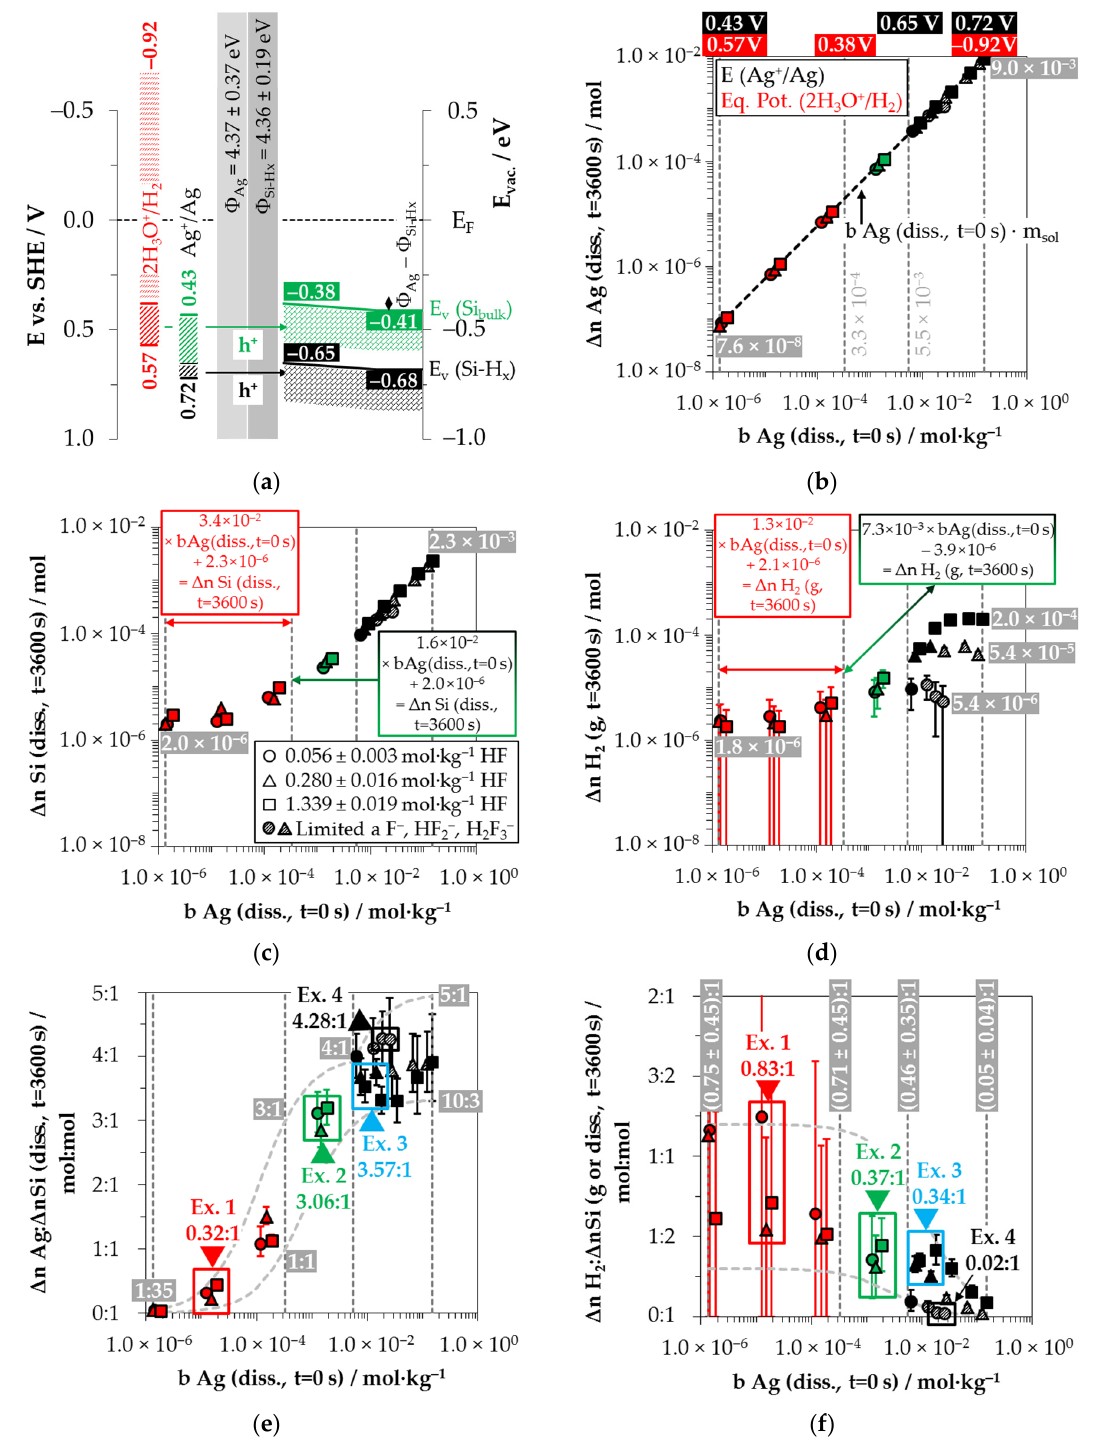
Figure 2. ( a ) Energy diagram of Ag + and H 3 O + reduction at the Ag/Si contact with the indication of the upper and lower limits of the redox strengths of the Ag + /Ag half-cell [28] and those of the equilibrium potentials of the 2H 3 O + /H 2 half-cell [33] and energetic levels of the valence bands of the bulk and hydrogen-terminated silicon ( E V (Si bulk ) [26,80,81], E V (Si-H x ) [82]) and their bending, based on the differences of Φ Ag and Φ Si-Hx [83–88] and the findings from [26]; ( b ) amounts of Ag deposition ( Δ n Ag ( diss., t = 3600 s)); ( c ) Si dissolution ( Δ n Si ( diss., t = 3600 s)); and ( d ) molecular H 2 formation ( Δ n H 2 ( g, t = 3600 s)) after t = 3600 s processing, as well as stoichiometric ratios of ( e ) Ag deposition and Si dissolution ( Δ n Ag : Δ n Si (diss., t = 3600 s)); and ( f ) stoichiometric ratios of molecular H 2 formation and Si dissolution ( Δ n H 2 : Δ n Si (g or diss., t = 3600 s)) relative to the initial Ag + molality b Ag ( diss., t = 0 s).